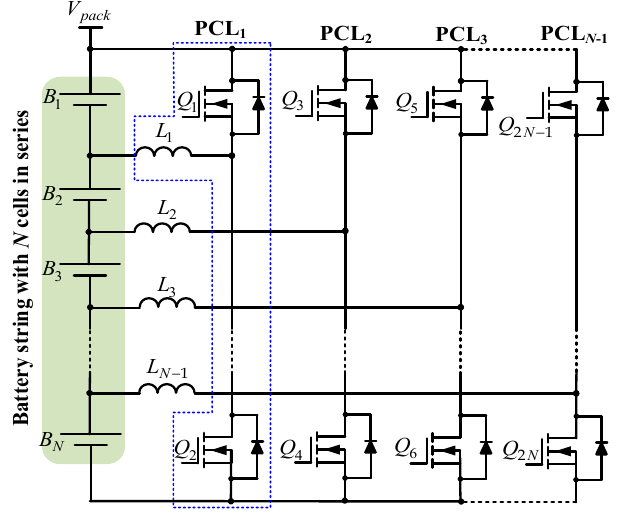
Figure 1. Architecture of the studied equalizer power stage with ( N − 1) converter legs in parallel.